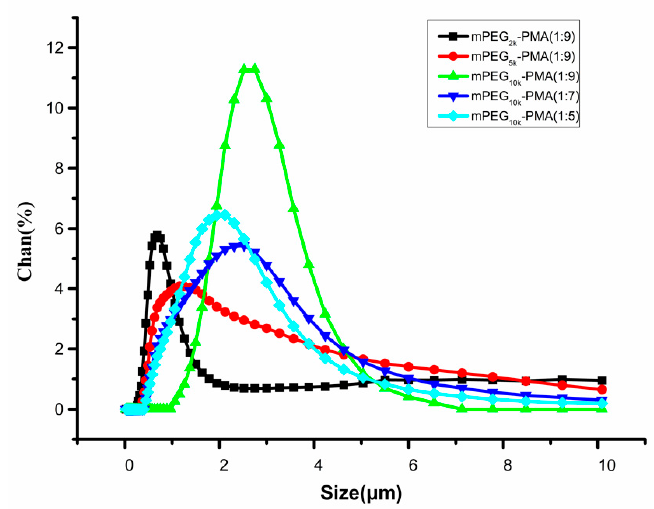
Figure 3. Size distribution of drug-loaded microspheres with di ff erent